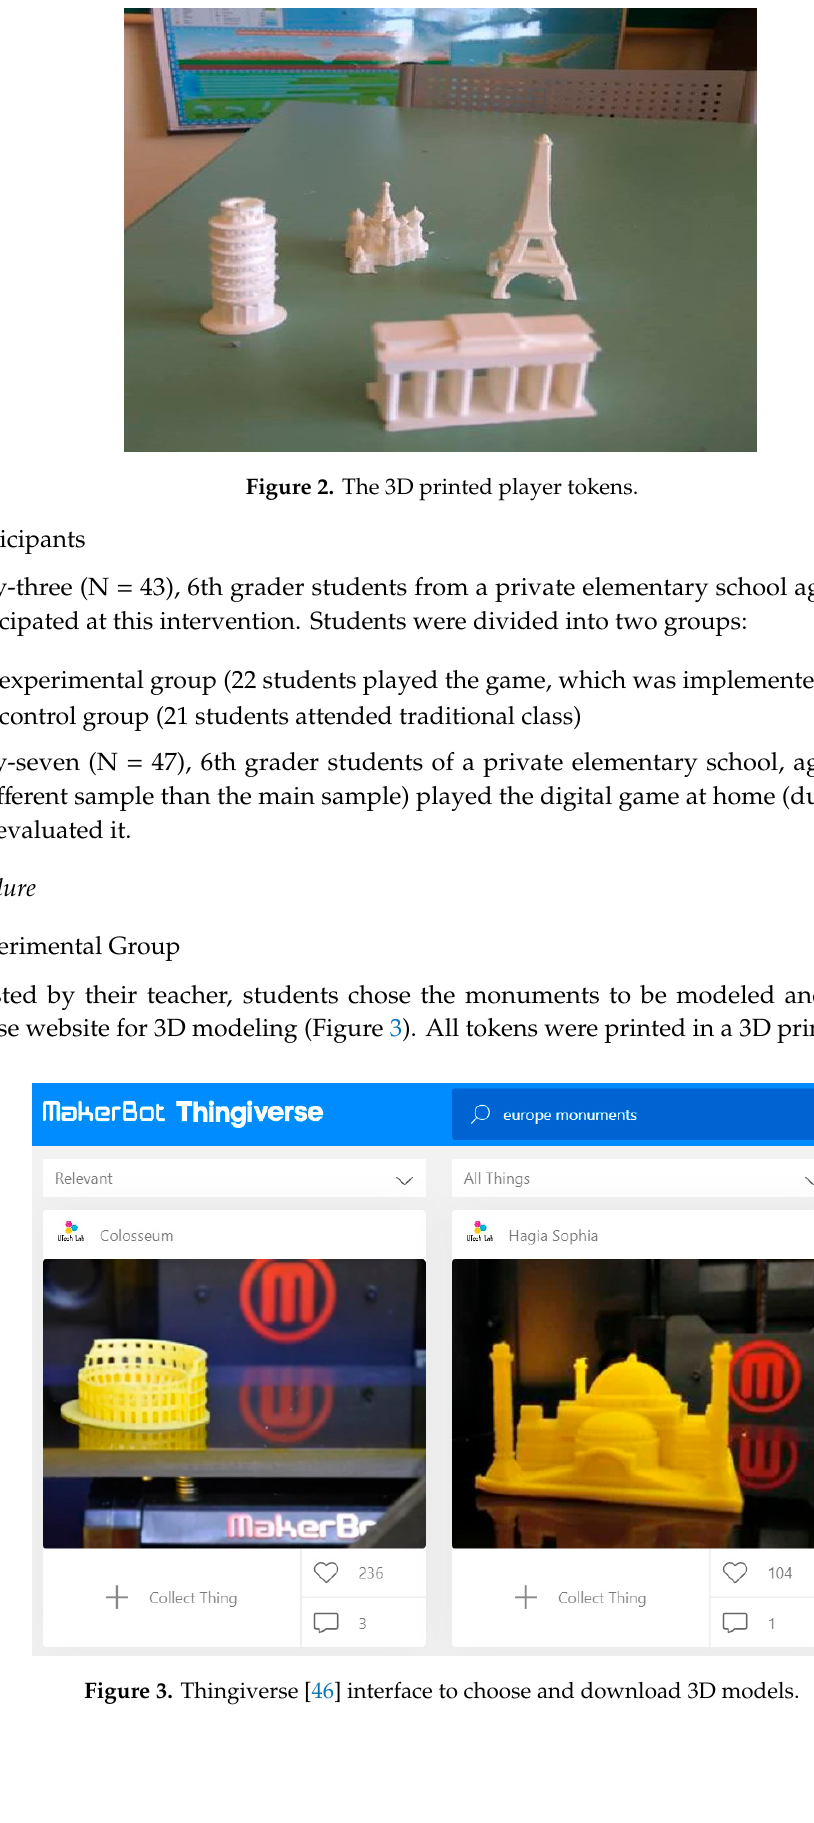
( c ) Figure 1. The Geopoly game board and cards from the game [45]. ( a ) The adapted game board and 3D printed player tokens; ( b ) a monument card (utility card); ( c ) a property card.